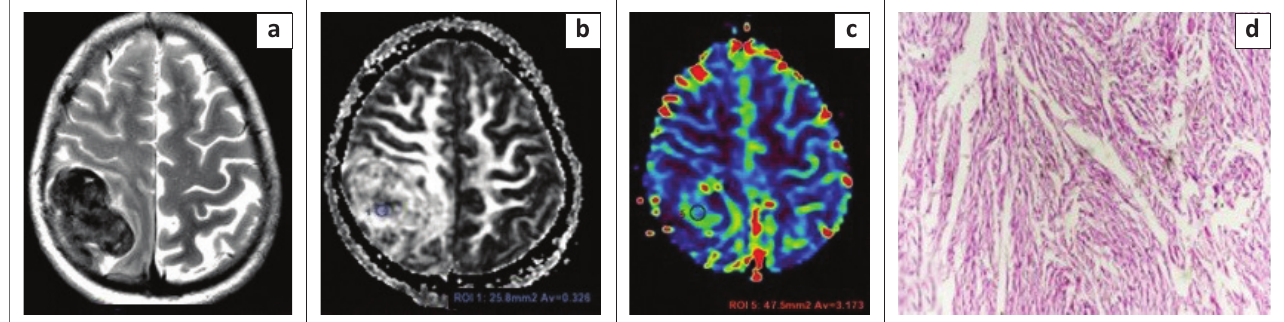
FIGURE 1: Images of a 40-year-old female who presented with headache. Axial T2WI (a) demonstrates the typical hypointense appearance of a fibroblastic meningioma. The lesion reveals a high fractional anisotropy value (b), and lower relative cerebral blood volume (c) value. The patient underwent surgery and histopathological photomicrograph (d) indicated tumour comprised of sheets of spindle cells with indistinct cell boundaries (Hematoxylin and eosin staining, ×10) confirming a fibroblastic meningioma.